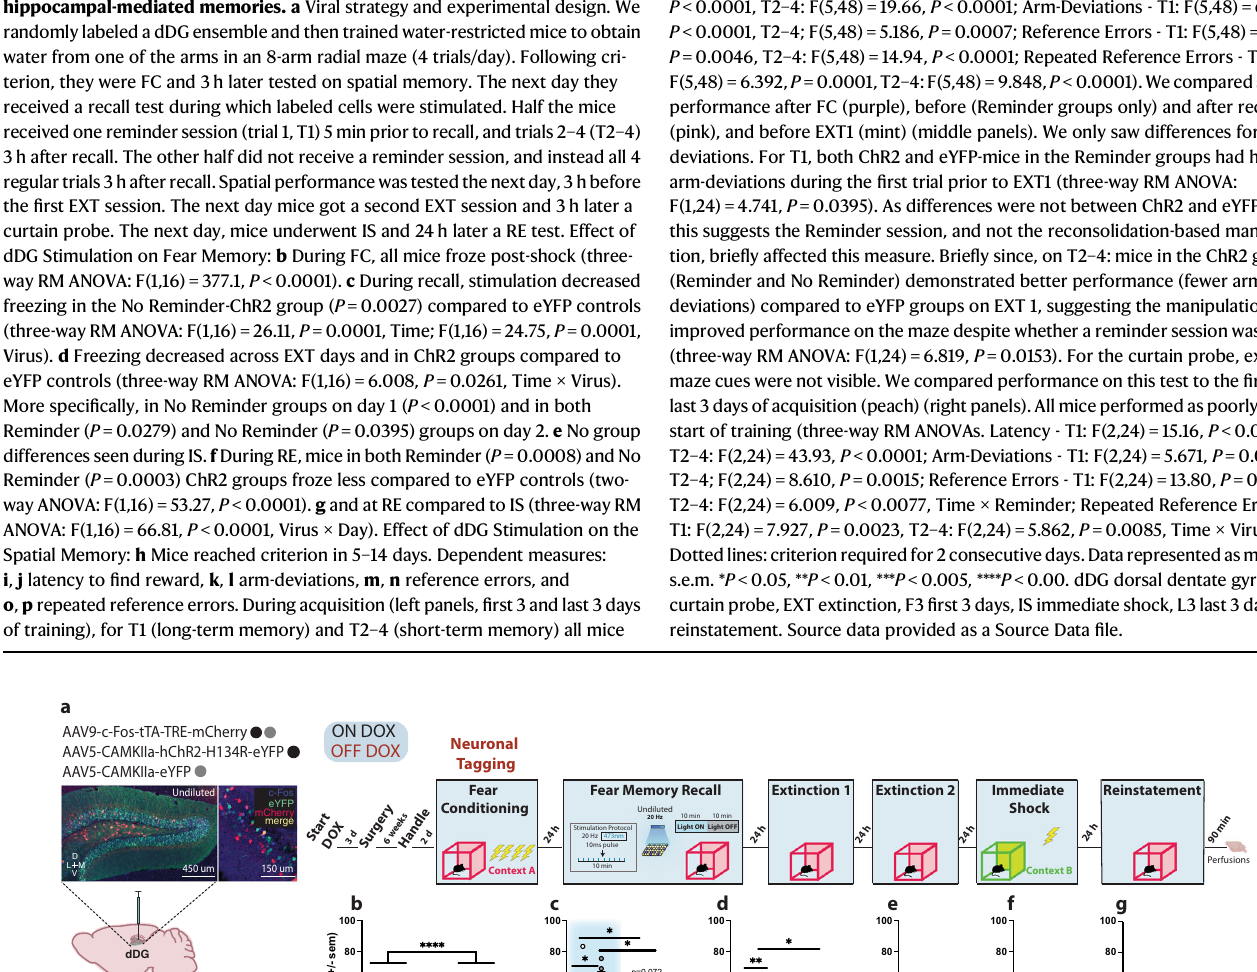
Fig.5|dDGinterferenceisspeci fi ctothefearmemoryanddoesnotaffectother hippocampal-mediated memories. a Viral strategy and experimental design. We randomlylabeledadDGensembleandthentrainedwater-restrictedmicetoobtain water from one of the arms in an 8-arm radial maze (4 trials/day). Following cri- terion, they were FC and 3h later tested on spatial memory. The next day they received a recall test during which labeled cells were stimulated. Half the mice receivedoneremindersession(trial1,T1)5minpriortorecall,andtrials2 – 4(T2 – 4) 3h after recall. The other half did not receive a reminder session, and instead all 4 regulartrials3hafterrecall.Spatialperformancewastestedthenextday,3hbefore the fi rst EXT session. The next day mice got a second EXT session and 3h later a curtain probe. The next day, mice underwent IS and 24h later a RE test. Effect of dDG Stimulation on Fear Memory: b During FC, all mice froze post-shock (three- way RM ANOVA: F(1,16)=377.1, P <0.0001). c During recall, stimulation decreased freezing in the No Reminder-ChR2 group ( P =0.0027) compared to eYFP controls (three-wayRM ANOVA: F(1,16)=26.11, P =0.0001, Time; F(1,16)=24.75, P =0.0001,